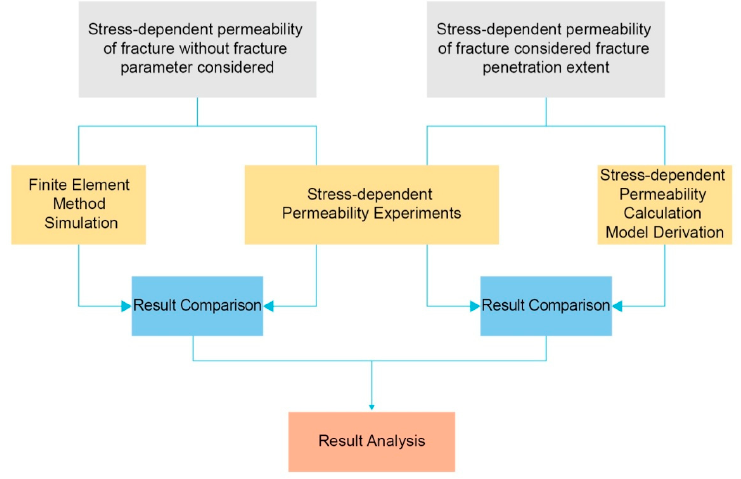
Figure 1. The technology roadmap of the work.